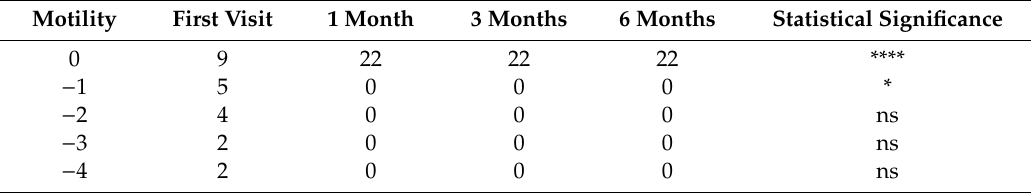
Table 3. Vertical and horizontal five-point scale (0 to − 4) for 22 patients treated with collagen membrane. Motility